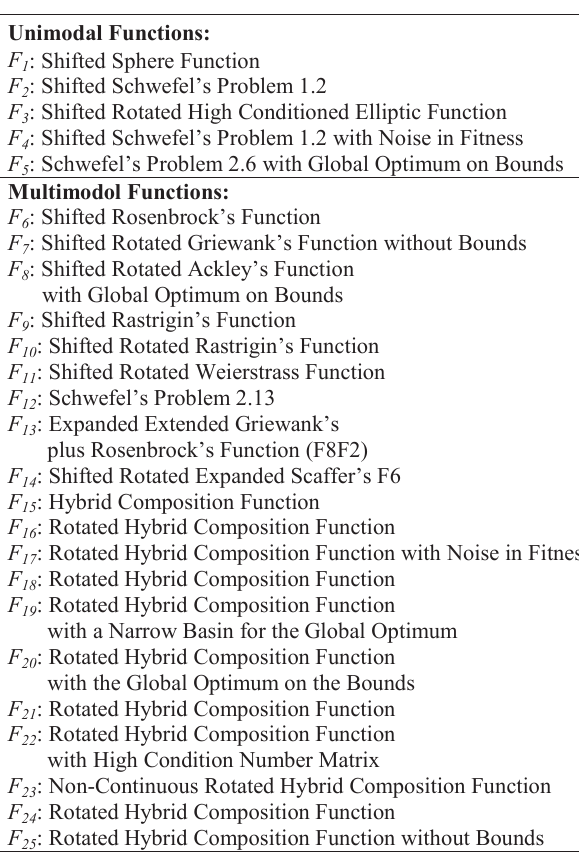
Table 13. The CEC 2005 benchmark